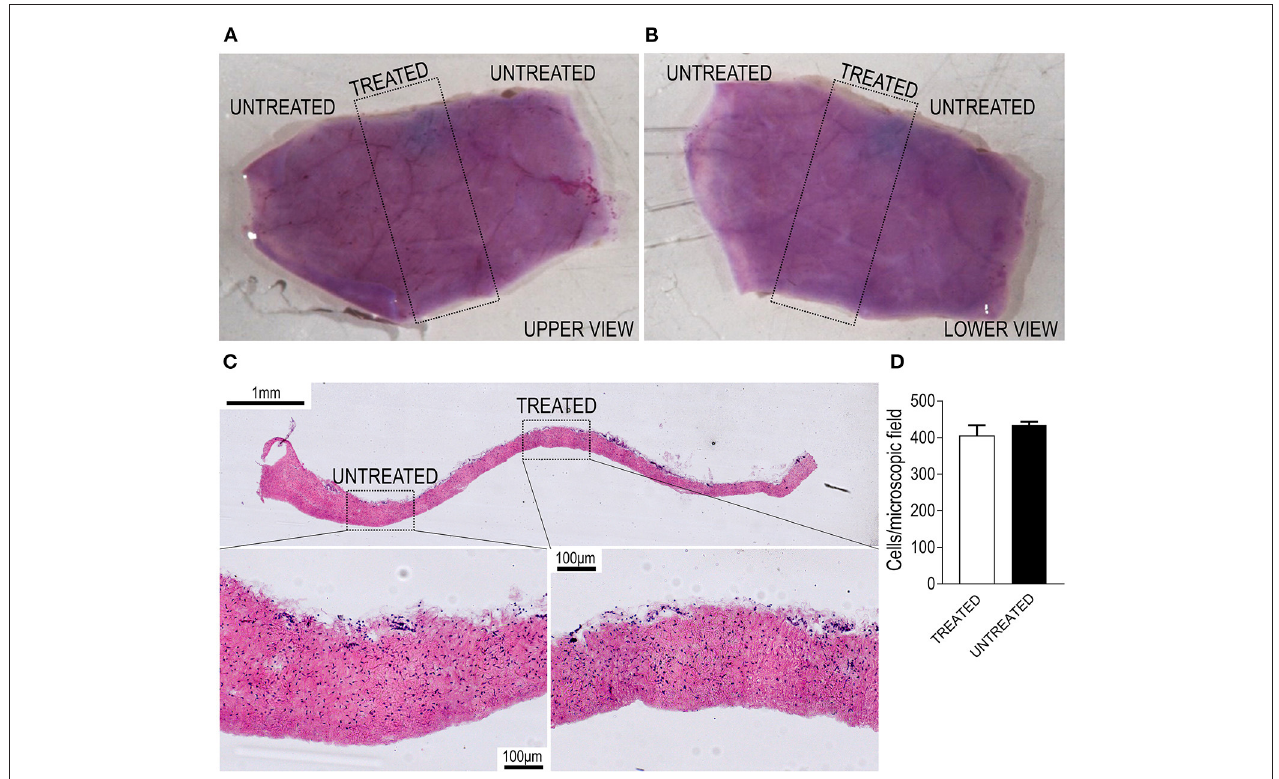
FIGURE 2 | Validation of the TDD on living porcine pericardium. (A,B) Show the two sides of a pericardial patch stained with 3-(4.5-dimethylthiazol-2-yl)2,5-diphenyltetrazolium bromide (MTT; purple color). The region encircled by the dotted rectangle indicates the part that was exposed to shockwaves and does not exhibit any staining reduction, suggesting maintenance of an excellent vitality of the tissue. (C) Shows the transversal section of another section of living pericardium treated with the TDD. It is evident from the high magnifications in the lower part of the panels that cells in the treated regions are in the same amount as in the untreated portions. Quantifications of nuclei are present in D , showing no difference in the nuclei counting in treated vs. untreated portions. Bar graph displays the mean and the SE of data ( n = 3 independently treated pericardial samples; p > 0.05 by paired Student’s t